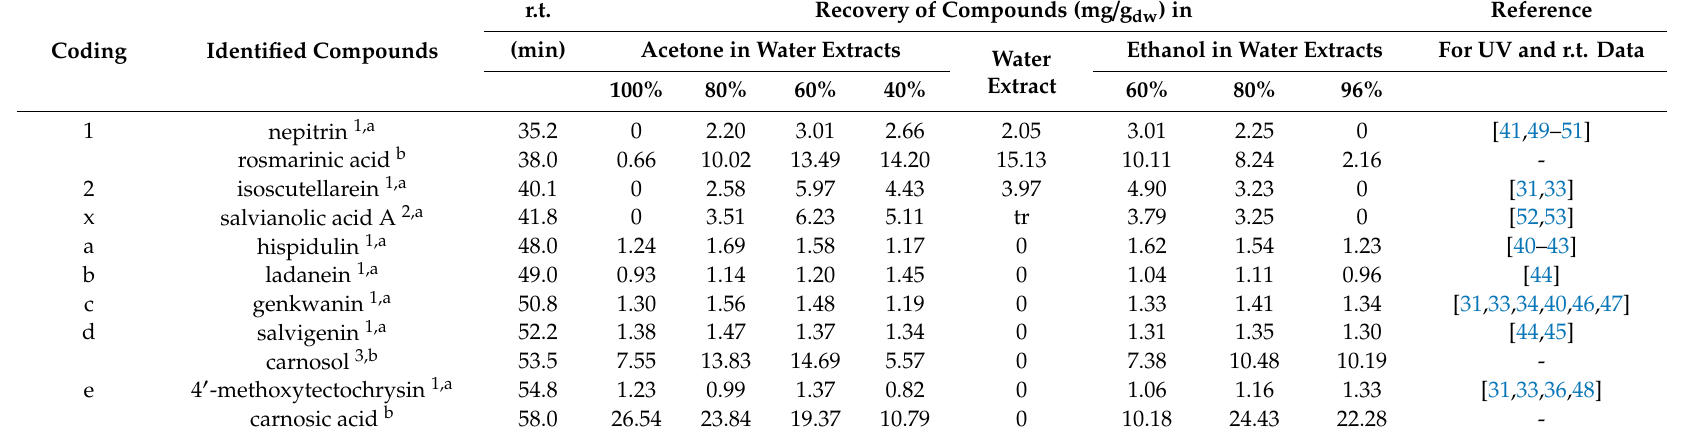
Table 3. Tentative identification of the phenolic components of the extracts obtained by di ff erent ethanol or acetone concentration, after 70 min of extraction, at 22 ◦ C, solid-to-liquid ratio 1:20, and non-specific particle size. r.t. Recovery of Compounds (mg / g dw ) in Reference Ethanol in Water Extracts For UV and r.t. Coding Identified Compounds Water Extract